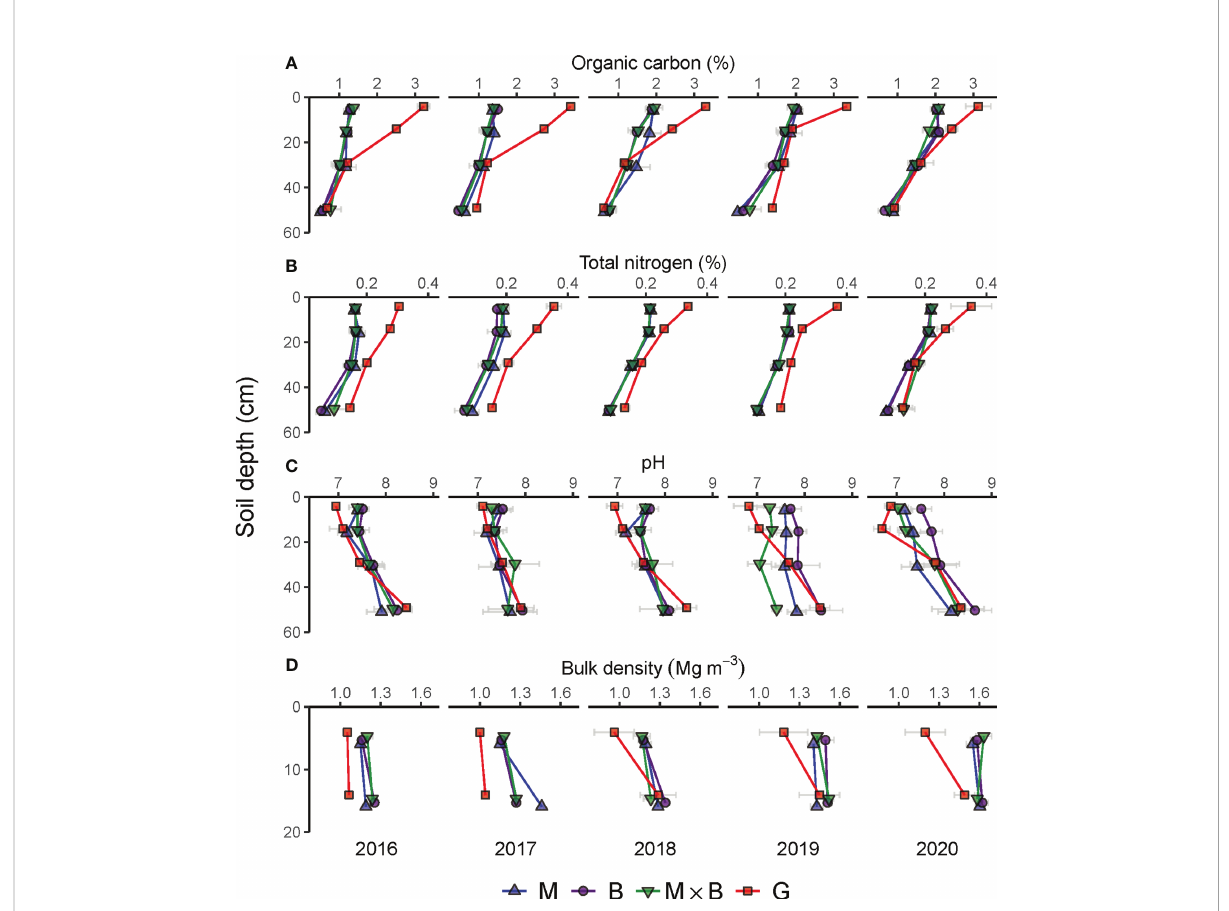
FIGURE 4 Year-to-year variations in soil physical and chemical properties during the experimental period from 2016 to 2020 under the monocultures of alfalfa (M), smooth bromegrass (B), and the M×B mixture in comparison with a natural grassland (G). Grey horizontal bars represent the range of mean ± one standard error. (A) , soil organic carbon content (%); (B) , soil total nitrogen content (%); (C) , soil pH; (D) , soil bulk density (Mg m -3